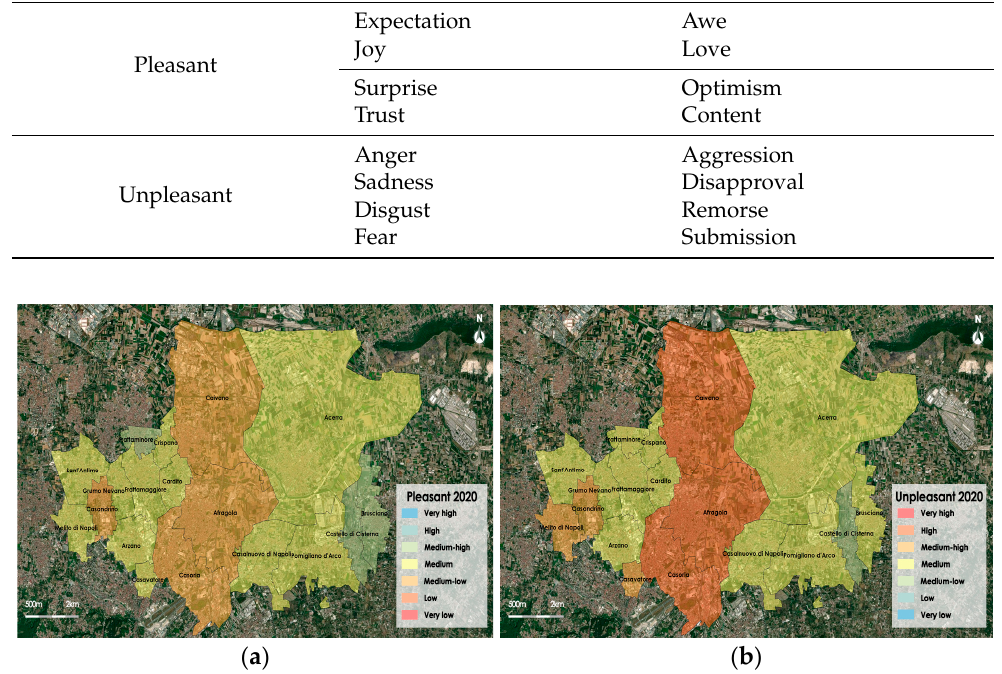
Figure 6. Pleasant and unpleasant emotion relevance thematic maps in the year 2020. ( a ) Pleasant emotion relevance. ( b ) Unpleasant emotion